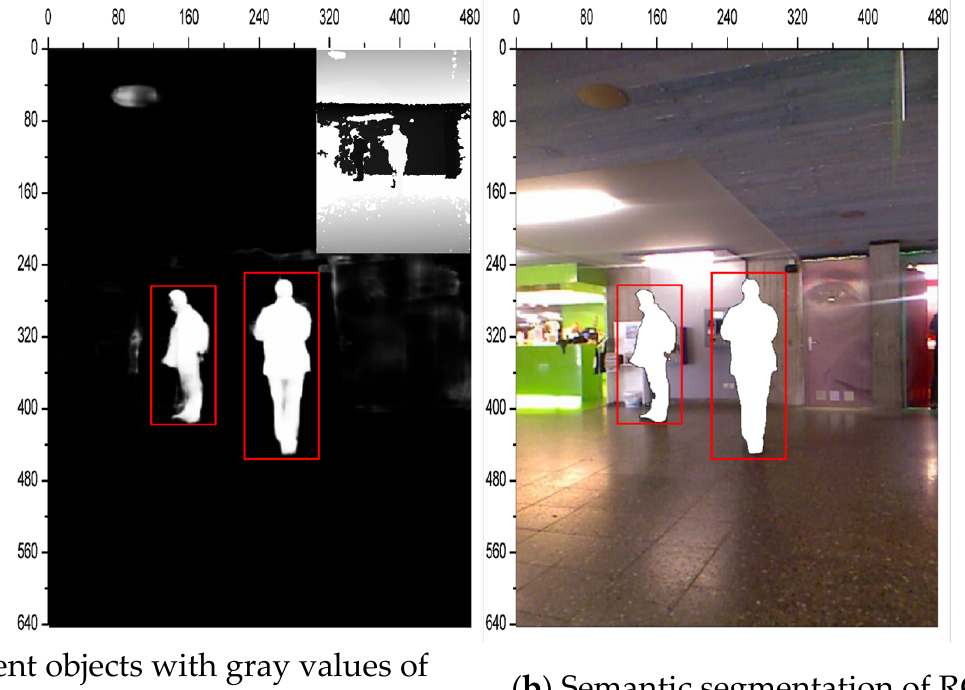
Figure 9. In the same coordinate system, we set the RGB’s three channels to 255, where the coordinates are identical to the salient objects’ coordinates in grayscale images. The salient objects’ coordinates in grayscale images are where the gray values are greater than 200. Here the threshold of 200 is set according to the imaging effect of the salient objects in the grayscale image (Confidence: Left person 0.951, Right person 0.969).